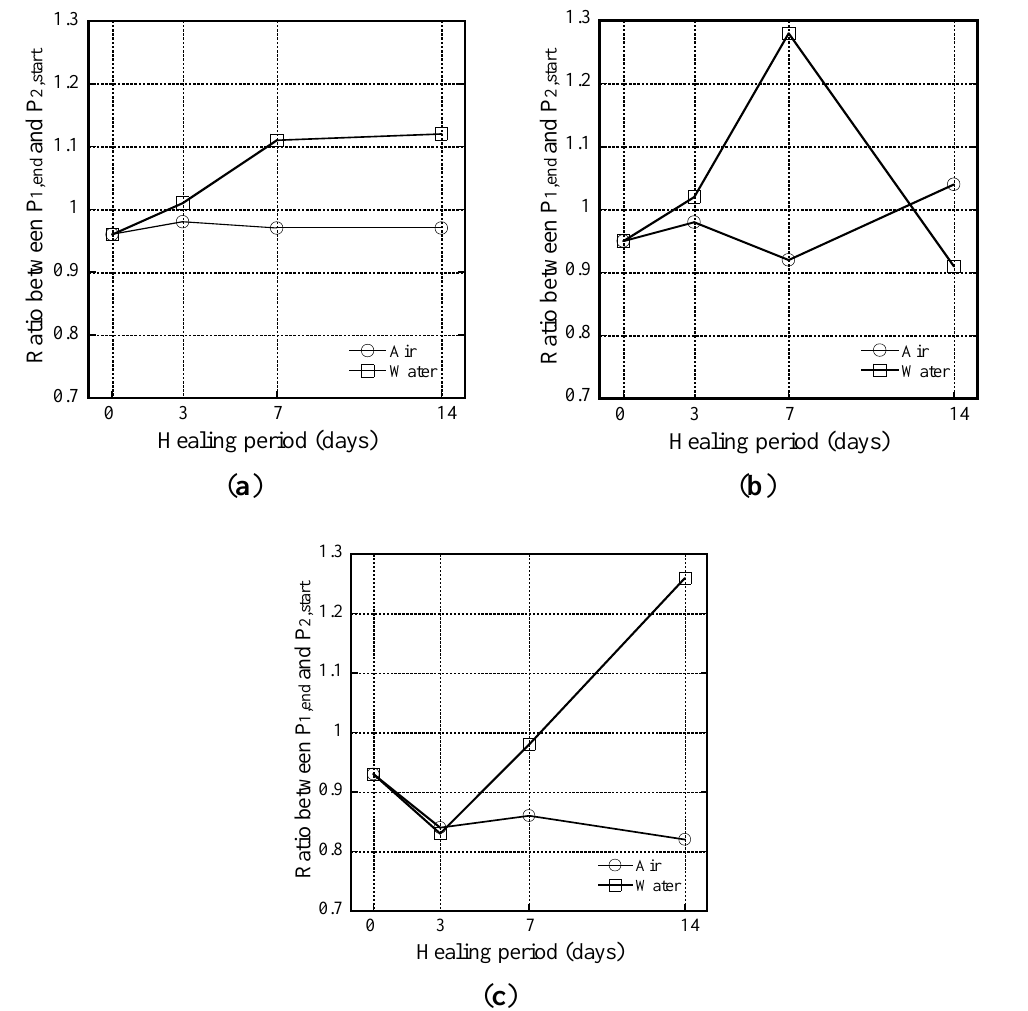
Figure 6. Ratio between P ( a ) Hooked fiber; ( b ) Smooth fiber; ( c ) Twisted